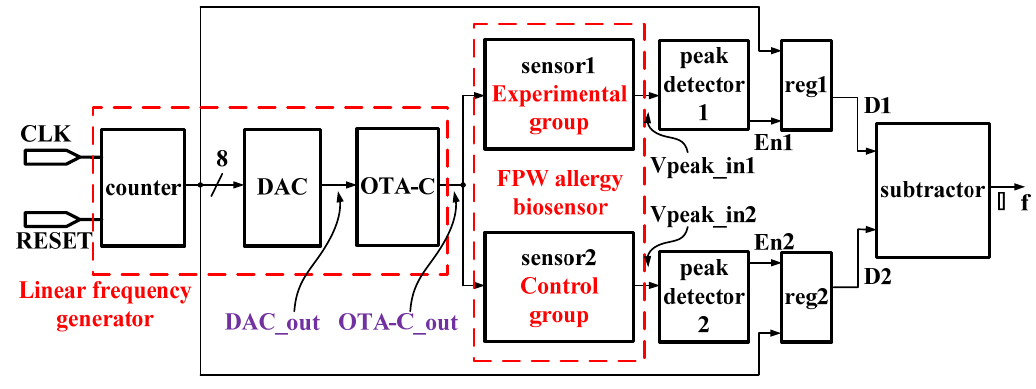
Figure 8. Block diagram of the frequency-shift readout